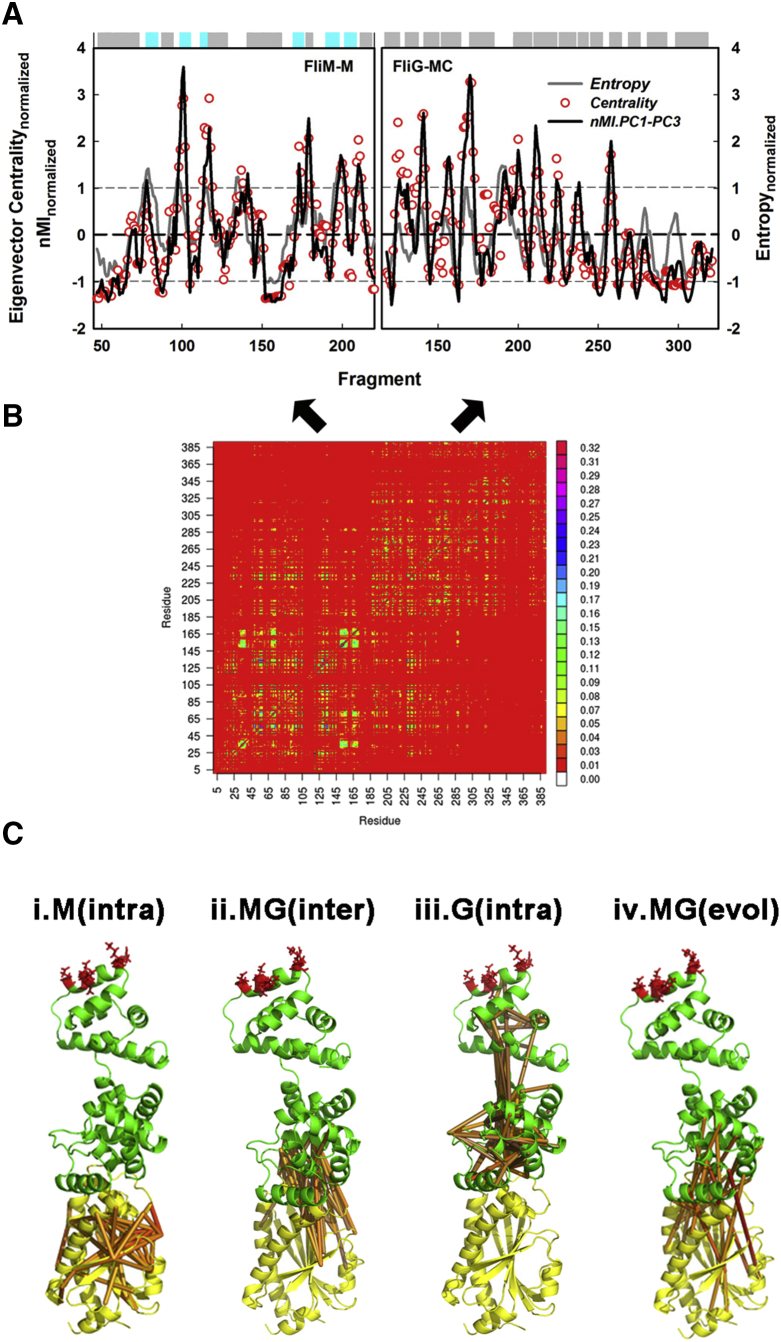
Network Analysis of Local Correlations(A) The eigenvector centrality tracks the averaged nMIPC profile for the PC1-PC3 motions (FliMM Pcorr = 0.96; FliGMC Pcorr = 0.90). Fragment centrality and entropy are correlated (FliMM Pcorr = 0.44; FliGMC Pcorr = 0.13). Horizontal bar shows secondary structure profile as in Figure 2B.(B) The covariance matrix. Side bar shows nMIlocal color scale.(C) The top (nMI > 0.15; red [high] − bluish brown [low]) (i) FliMM intra-domain, (ii) FliMMFliGM inter-subunit, and (iii) FliGMC intra-domain correlations; and (iv) top coevolved inter-subunit couplings mapped onto the PDB: 4FHR structure, color-coded as in Figure 1.See also Figures S3 and S4.